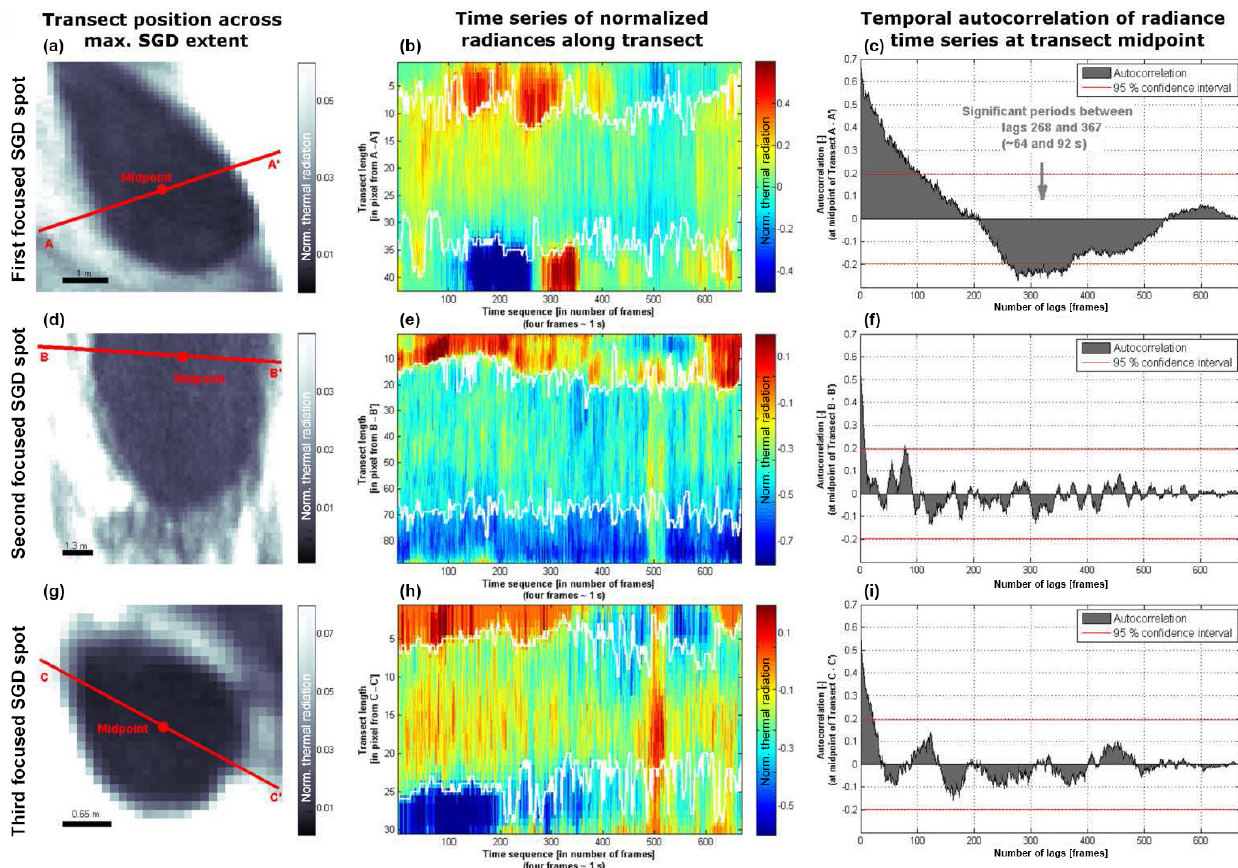
Figure 5. Analyses of spatio-temporal behaviour and potential periodicity of SGD spots are presented. Panels (a), (d), (g) show transects across the maximum extent and midpoint position of the SGD spot (subsets correspond to the red boxes shown in Fig. 3; note that the spatial scale varies between each spot indicated through the scale bar at the lower left of each subset). Panels (b), (e), (h) show the normalized thermal radiance (NTR) values along transects over time. The white lines indicate the boundary of the focused SGD spots. Panels (c), (f), (i) show the temporal autocorrelation of the NTR values along the entire time series obtained at the midpoint of the transect as described in Sect. 2 to detect possible